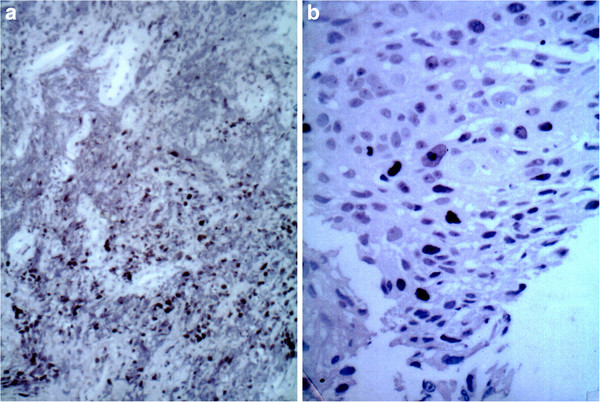
Positive immunostaining for p53, adenocarcinoma of the lung. b: Positive immunostaining for Ki67, squamous cell carcinoma of the lung.